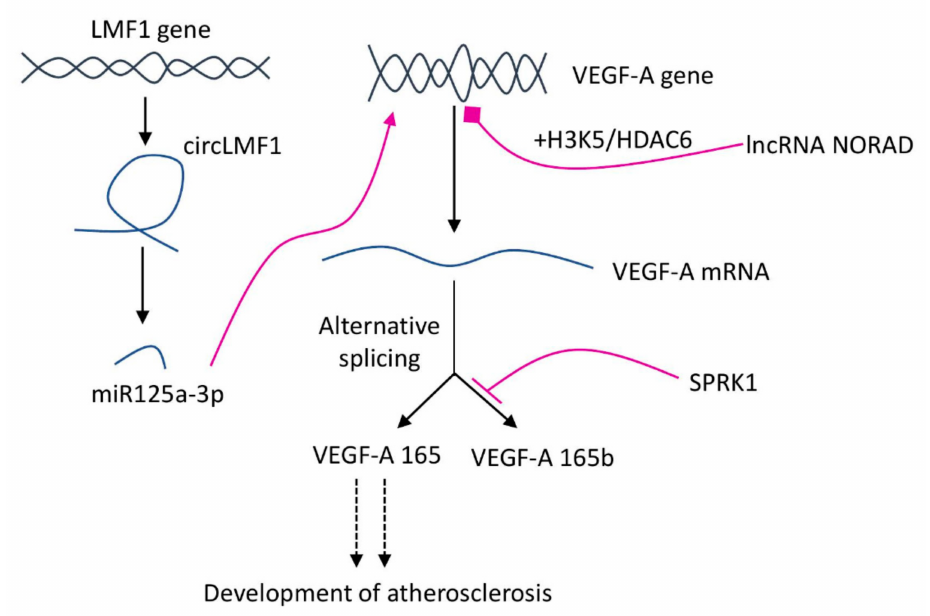
Figure 4. RNA-mediated regulation of VEGF-A expression and splicing isoforms balance. SPRK1 binds VEGF-A mRNA and shifts balance to the production of pro-angiogenic VEGF165. lncRNA NORAD (non-coding RNA activated by DNA damage) suppresses VEGF-A transcription with the help of H3K9 deacetylation and HDAC6 (Histone Deacetylase 6). Circular RNA originated from LMF1 (lipase maturation factor 1) interacts with miR-125a-3p, for which VEGF-A is a downstream